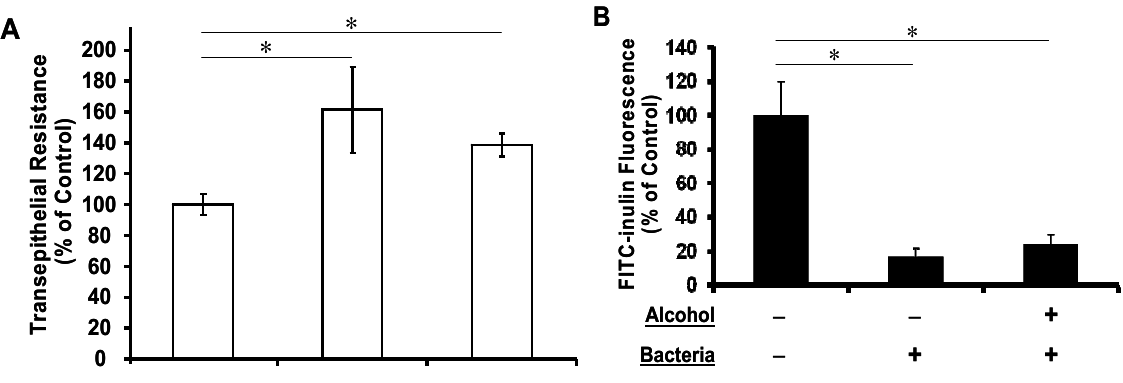
Figure 3. Effect of alcohol on epithelial integrity and transepithelial permeability under apical K. pneumoniae challenge. Polarized NHBE cells were challenged with ~10 MOIs of apical K. pneumoniae for 24 h in the absence (0 mM) or presence (100 mM) of basolateral alcohol for 24 h. ( A ) TEER measurements of NHBE cells showed a marked TEER increase with K. pneumoniae challenge as compared to the no alcohol treatment and no bacterial challenge control. Further, alcohol did not have any negative effect on such bacterium-induced TEER increase; ( B ) Similar to the TEER data, transepithelial FITC-inulin diffusion measurements indicated that K. pneumoniae challenge enhanced the epithelial barrier function by significant reduction in FITC-inulin transepithelial diffusion. Under this condition, alcohol exposure did not influence the K. pneumoniae effects on epithelial integrity. Asterisks denote statistically significant difference ( p ≤ 0.05, n =